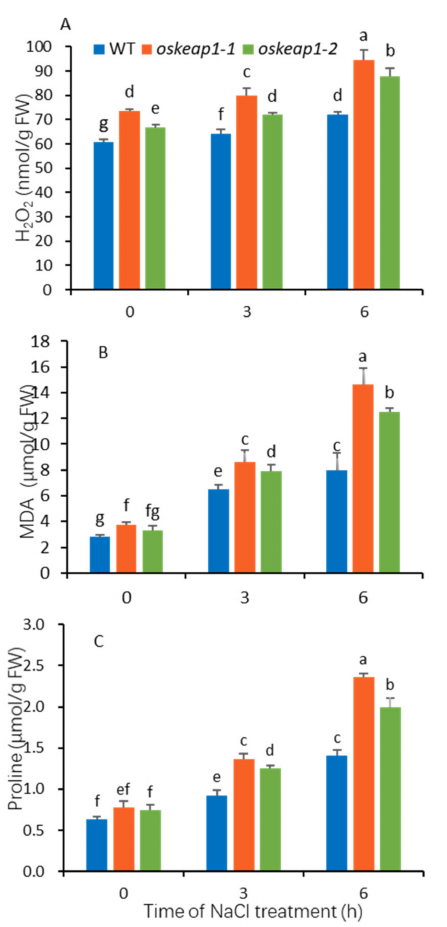
Figure 8. The content of H 2 O 2 , malondialdehyde (MDA), and proline in the above-ground tissues of Xidao #1 (WT) and its oskeap1 mutants. Ten-day-old seedlings were treated with 200 mM NaCl for 3 and 6 h. Data with di ff erent letters (a,b,c, etc.) are significantly di ff erent at the 0.05